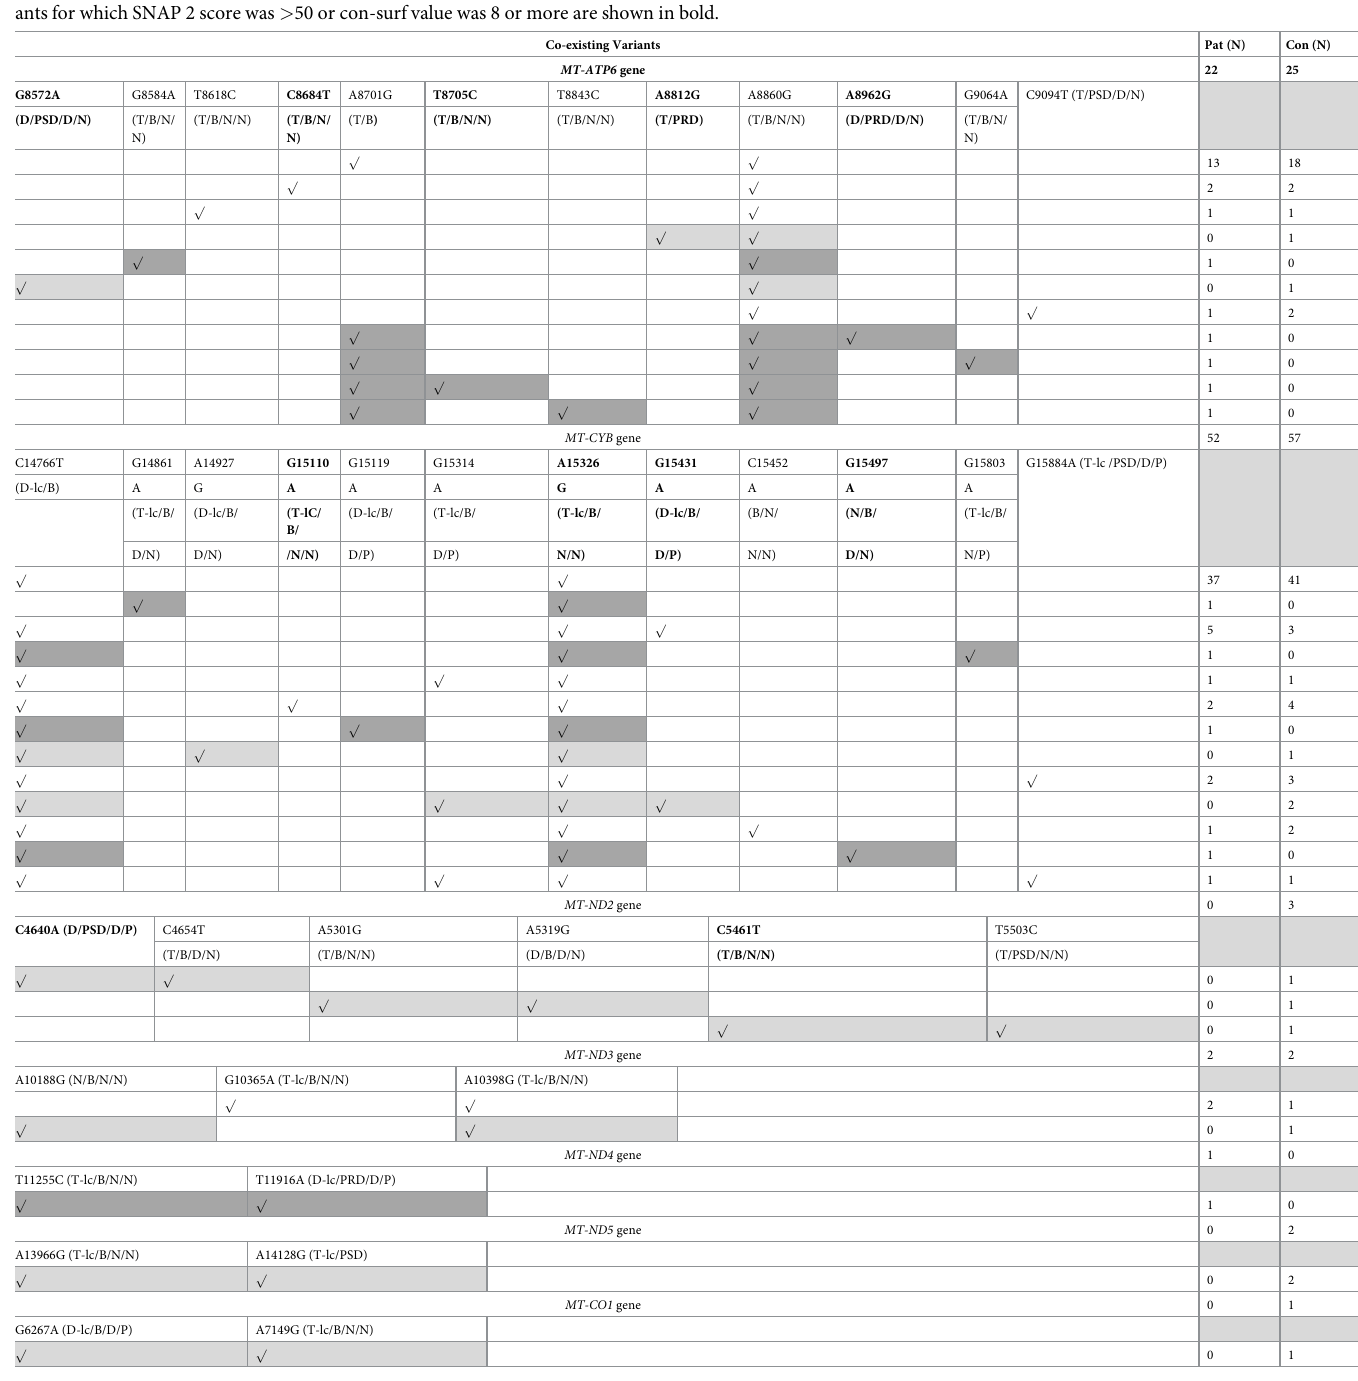
Dark grey: possible risk, light grey: possible protective effect, white: presumably neutral missense variation combinations B: Benign, Con: Controls, D: deleterious, lc: low confidence, N: neutral; P: pathogenic; Pat: Patients, PRD: probably damaging, PSD: possibly damaging, T: